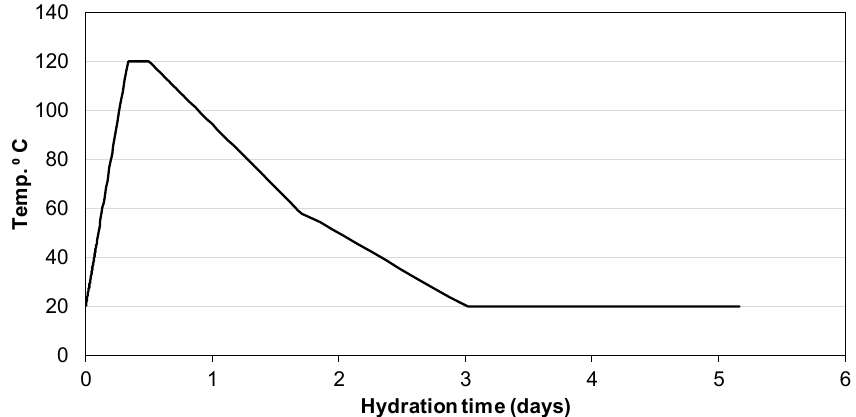
Figure 4. The temperature variation in the hydration calculations.